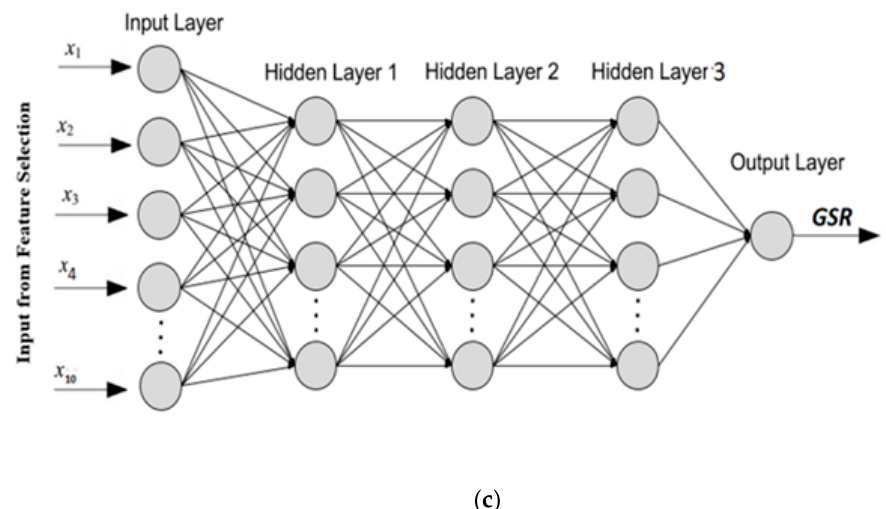
Figure 1. ( a ) Deep belief network algorithm flow chart. ( b ) The procedures to implement the deep belief network. ( c ) Topological structure of the deep neural network (DNN). RBM, restricted Boltzmann machine; GSR , global solar radiation.